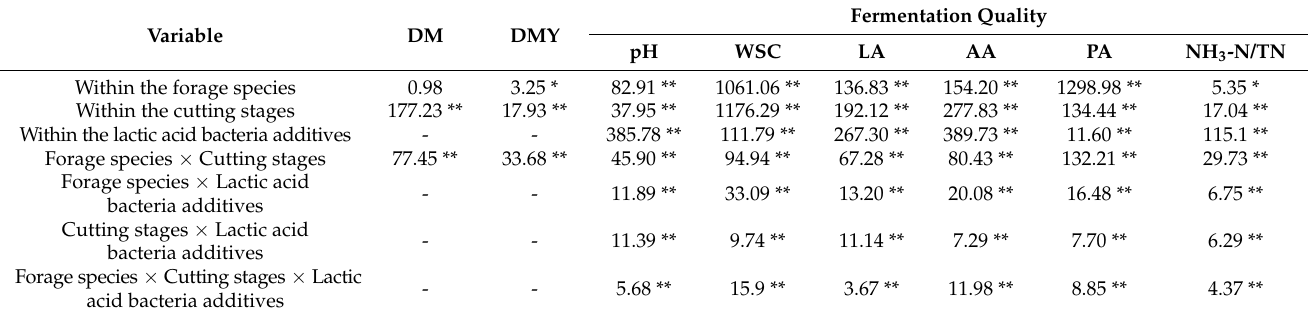
Table 1. Variance analysis of the differences in DM, DMY and fermentation quality of the